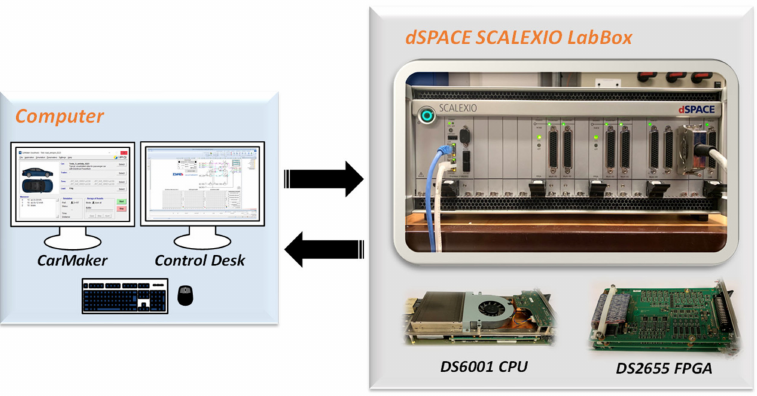
Figure 3. The real-time HIL system used in this